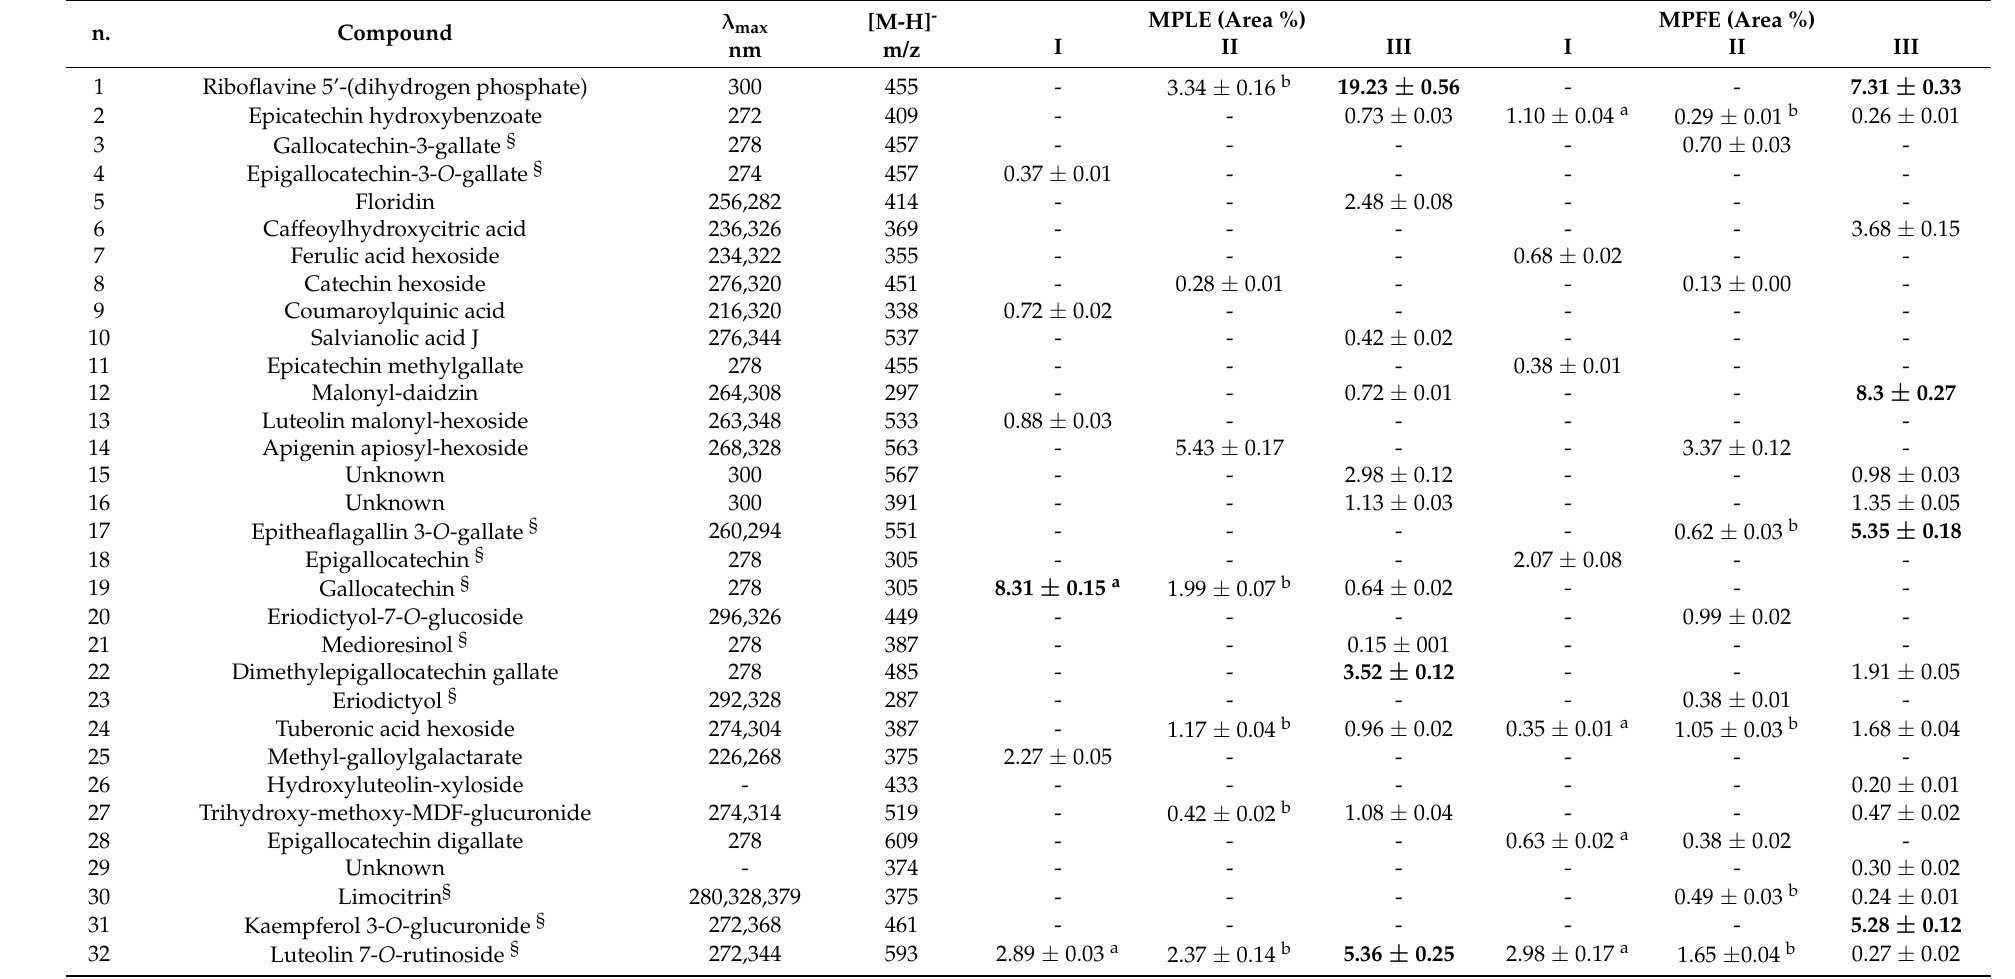
Table 3. Phytochemical profile of M. pulegium leaf and flower extracts (MPLE and MPFE, respectively) elucidated by LC-DAD-ESI-MS analysis. Results are expressed as mean area percentage (%) based on LC-DAD data acquired at 280 nm ± standard deviation of nine independent analyses in triplicate ( n = 3) with respect to the total area of identified and unidentified (unknown)